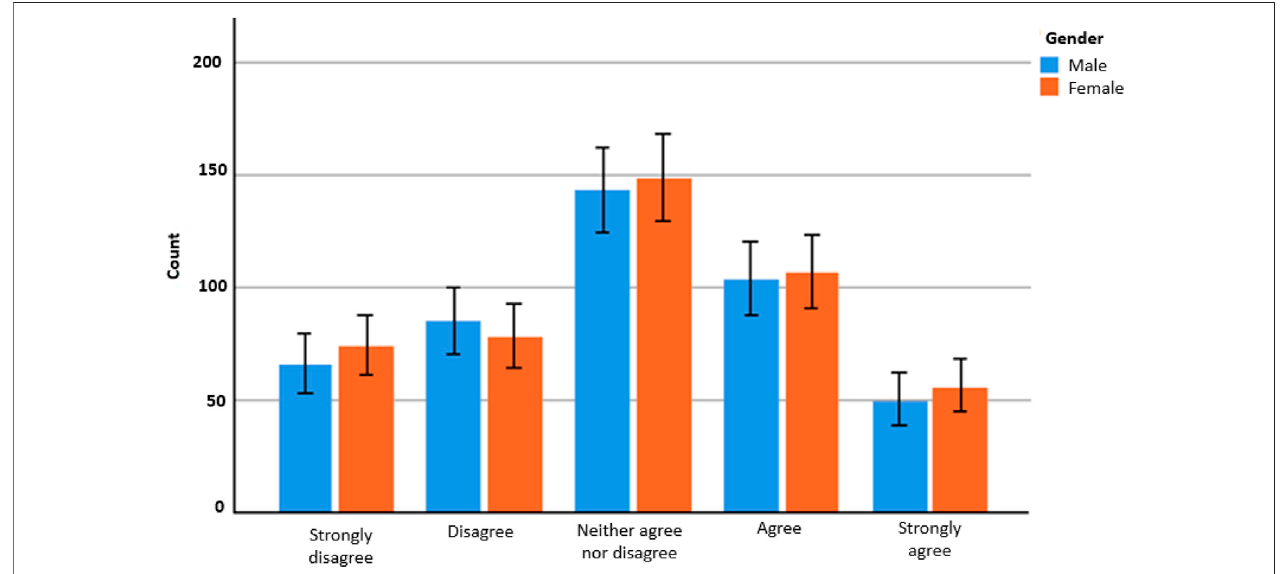
FIGURE 7 | Survey counts for ‘ Comfortableness of using smart systems to monitor menstruation or pregnancy ’ .Source, authors. Error bars indicate 95% con fi dence interval.